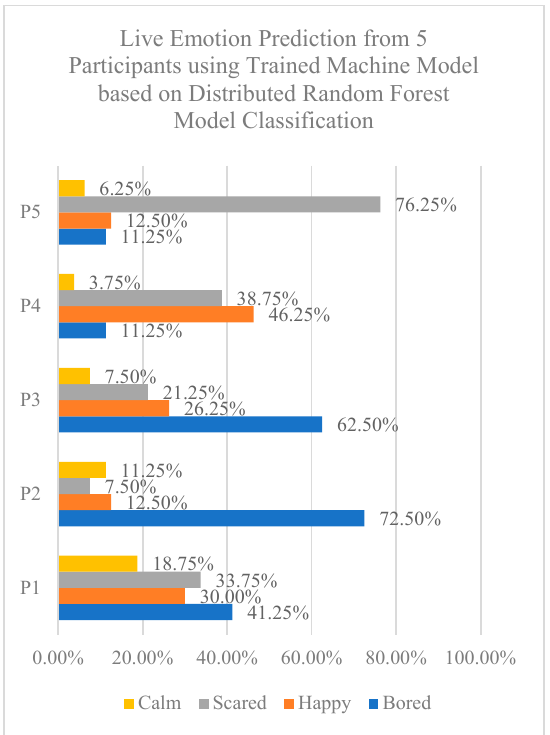
Figure 10. Results from live emotion prediction system using a four-channel EEG headset from a four-class predictor model.